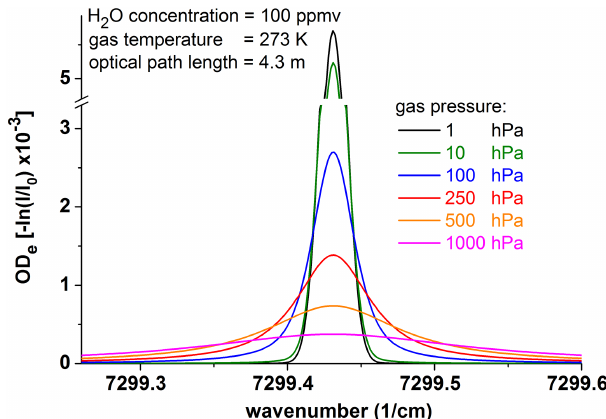
Figure 2. Simulated absorption profiles of the used (000–101, 110– 211) water vapour transition at 1370nm (7299.4cm − 1 ) at 100ppmv water vapour for the atmospheric pressure range between ground level and the mid-stratosphere. The line width is mainly influenced by the collisional, foreign broadening by air, inducing a Lorentzian line shape for gas pressures above 100hPa. At the lowest pressures of 1 and 10hPa the line shape (Gaussian) is mainly influenced by Doppler